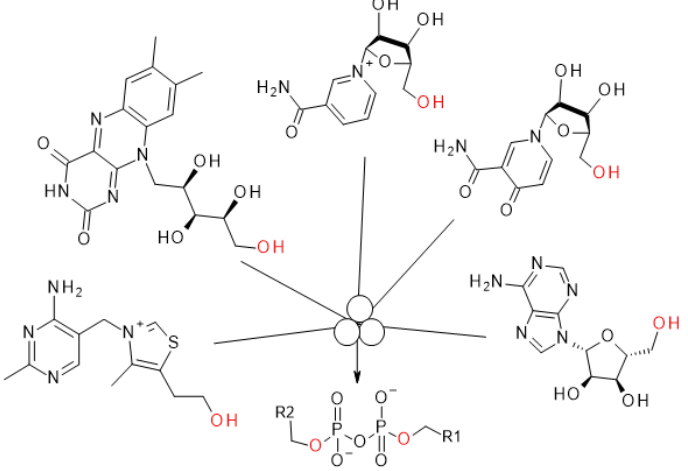
Figure 1. Pyrophosphates containing combination of vitamin B1-thiamine, B2-riboflavin, B3-nicotinamide riboside, 3-carboxamide-4-pyridone riboside and adenosine.